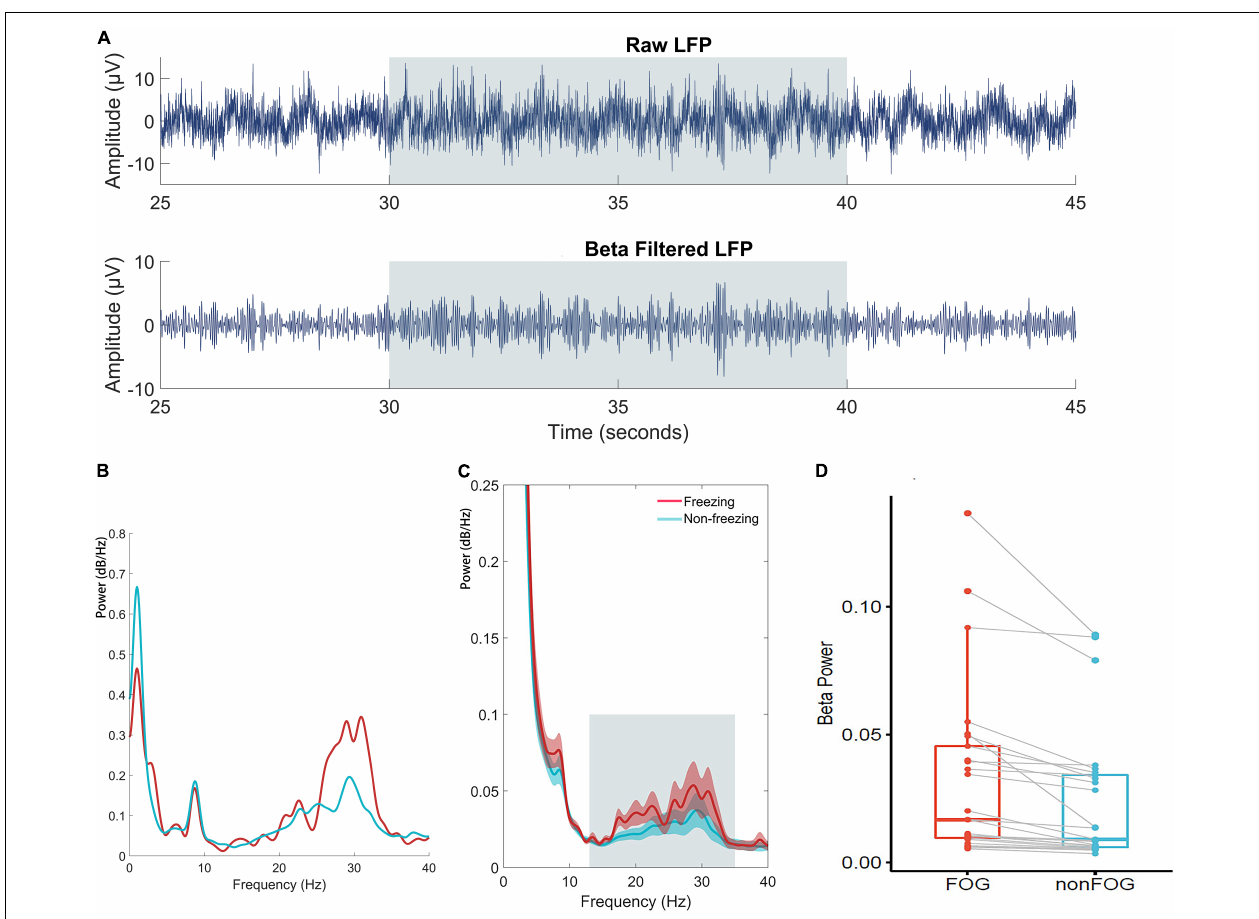
FIGURE 5 | (A) Time series of raw and beta band filtered LFP. (B) An individual case illustration of power spectrum density of LFP in the STN between freezing and non-freezing period; The red line represents the power spectrum of LFP during FOG, and the blue line represents the power spectrum of LFP during non-FOG. (C) The group analyze of power spectrum density averaged by all included walking epochs. The shaded error bar indicates SEM and the gray square indicates beta range. (D) Statistical comparison of averaged beta band power of LFP between conditions at trial level indicated significantly increased beta power during freezing ( P